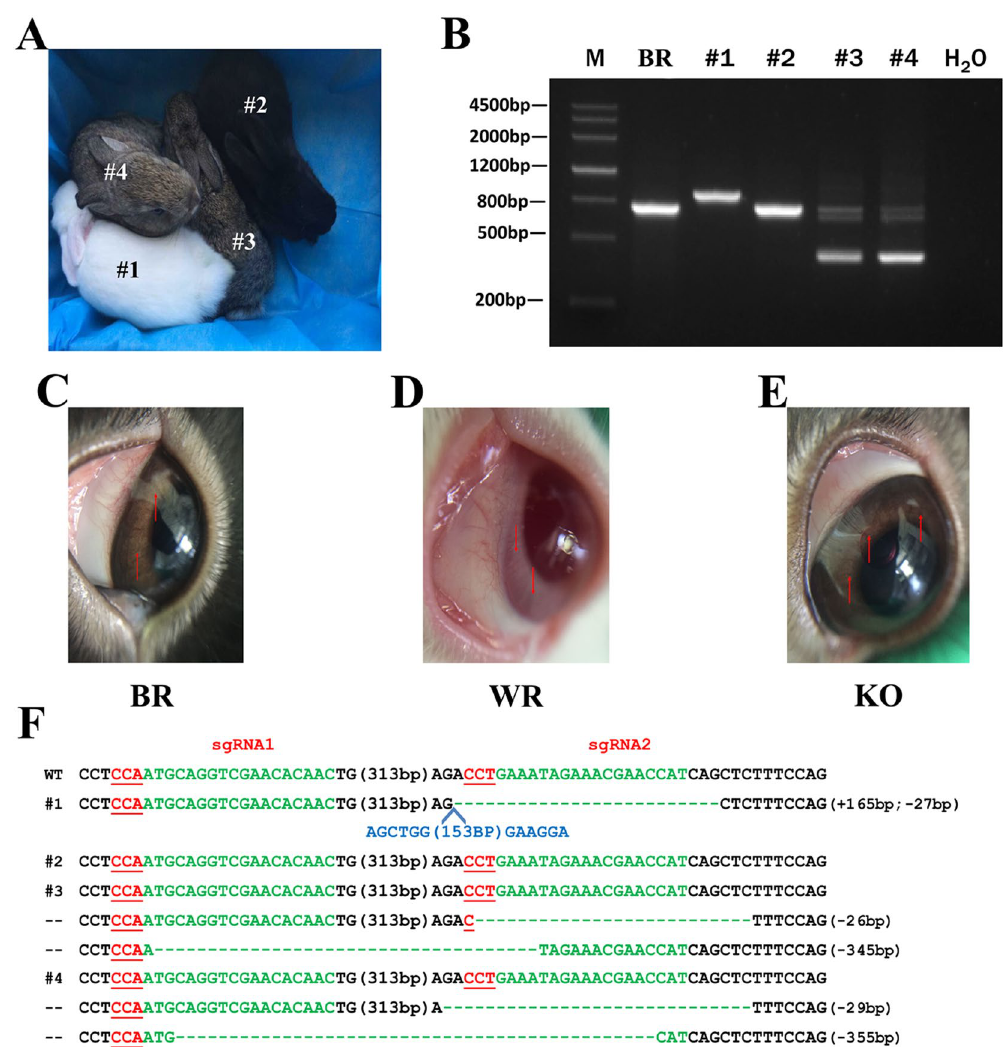
Figure 2. Generation of Tyr 3 ′ UTR deleted rabbit by CRISPR/Cas9. ( A ) Phenotype of Tyr mutant rabbits; rabbit #1, albinism; rabbit #2, black; rabbit #3 and #4, graying. ( B ) The mutation determination in founder rabbits by PCR. ( C ) The eye of black rabbit (BR). Original images are included “Authors’ original file for Fig. 2B”. ( D ) The eye of white rabbit (WR). ( E ) The eye of Tyr 3 ′ UTR deleted rabbit (KO). ( F ) Mutation detection in founder by T-cloning and Sanger sequencing. The PAM sites are underlined and highlighted in red; the target sequences are green; deletions ( − ) and insertions ( + ) are shown. WT,